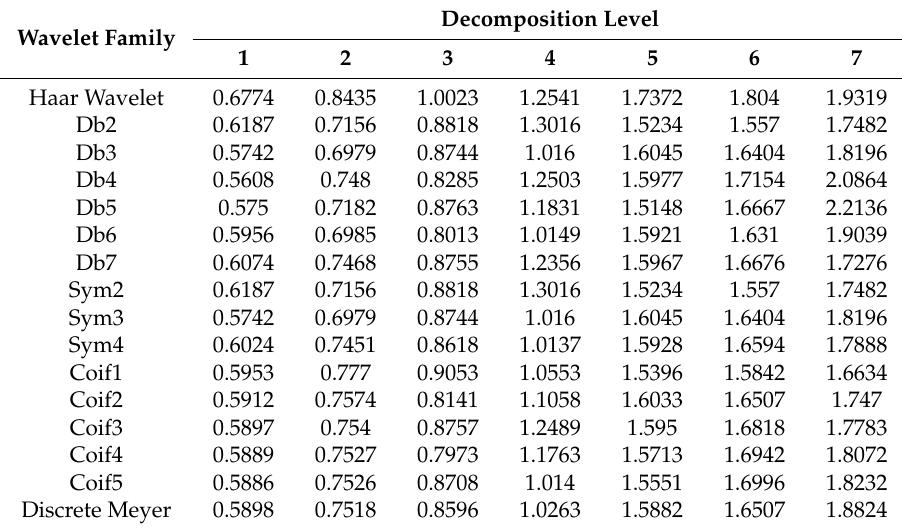
Figure A3. Plot of yield spreads constructed at the longer end of yield curve and their corresponding wavelet decompositions. ( a ) Sp (10, 5); ( b ) Sp (10, 8). Table A1. RMSE values of the wavelet decomposition.